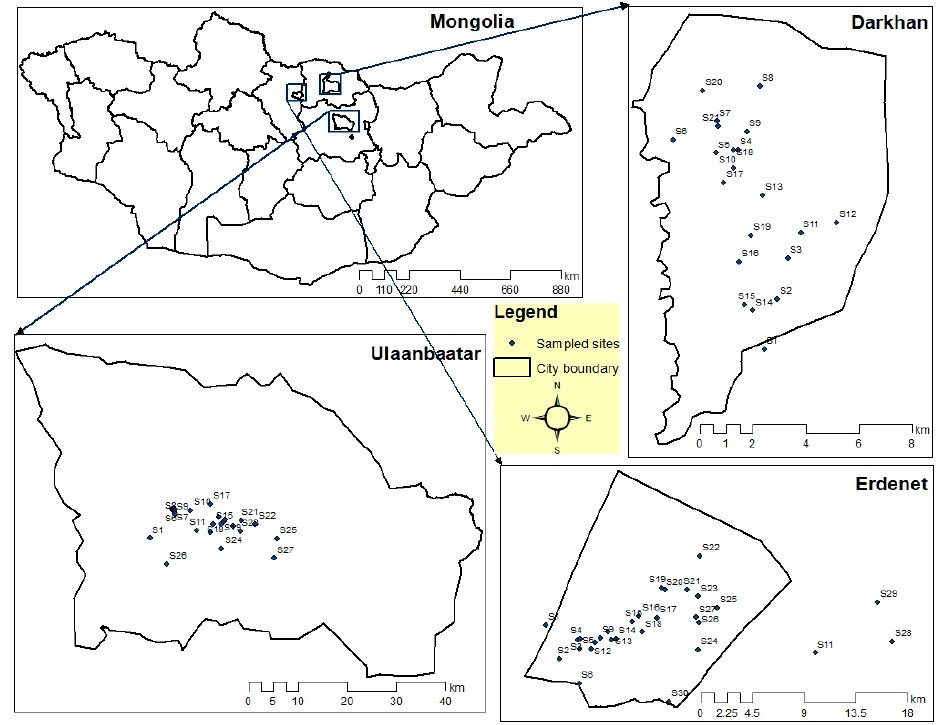
Figure 1. The position of samples taken from the study areas.